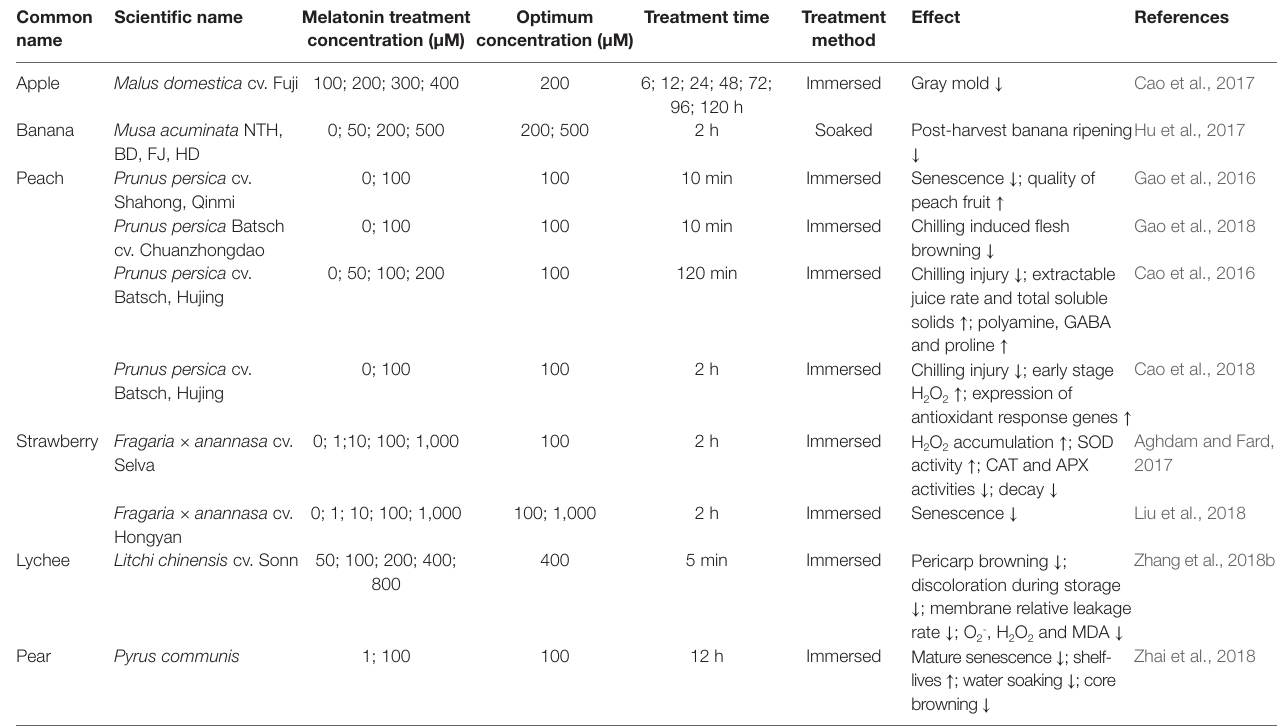
TABLe 3 | Effects of exogenous melatonin on the preservation and quality of post-harvest